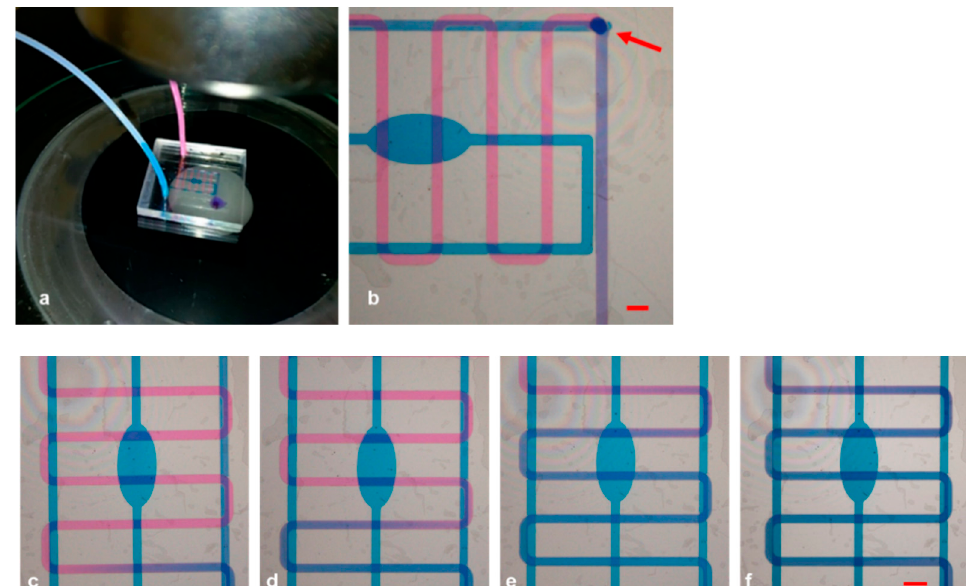
Figure 5. ( a ) Whole device connected to micropumps under the microscope; ( b ) frame acquired after complete mixing of pink and blue ink. ( c – f ) Modulation of flow rates, resulting in different mixing conditions of the inks. Scale bars: 500 µm.